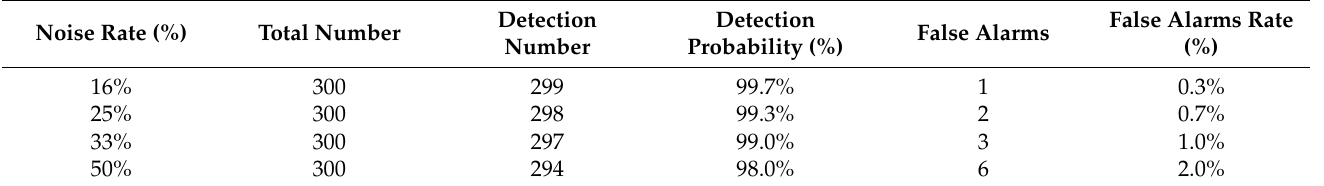
Table 4. Detection results of the networks trained by Co-correcting with different noise